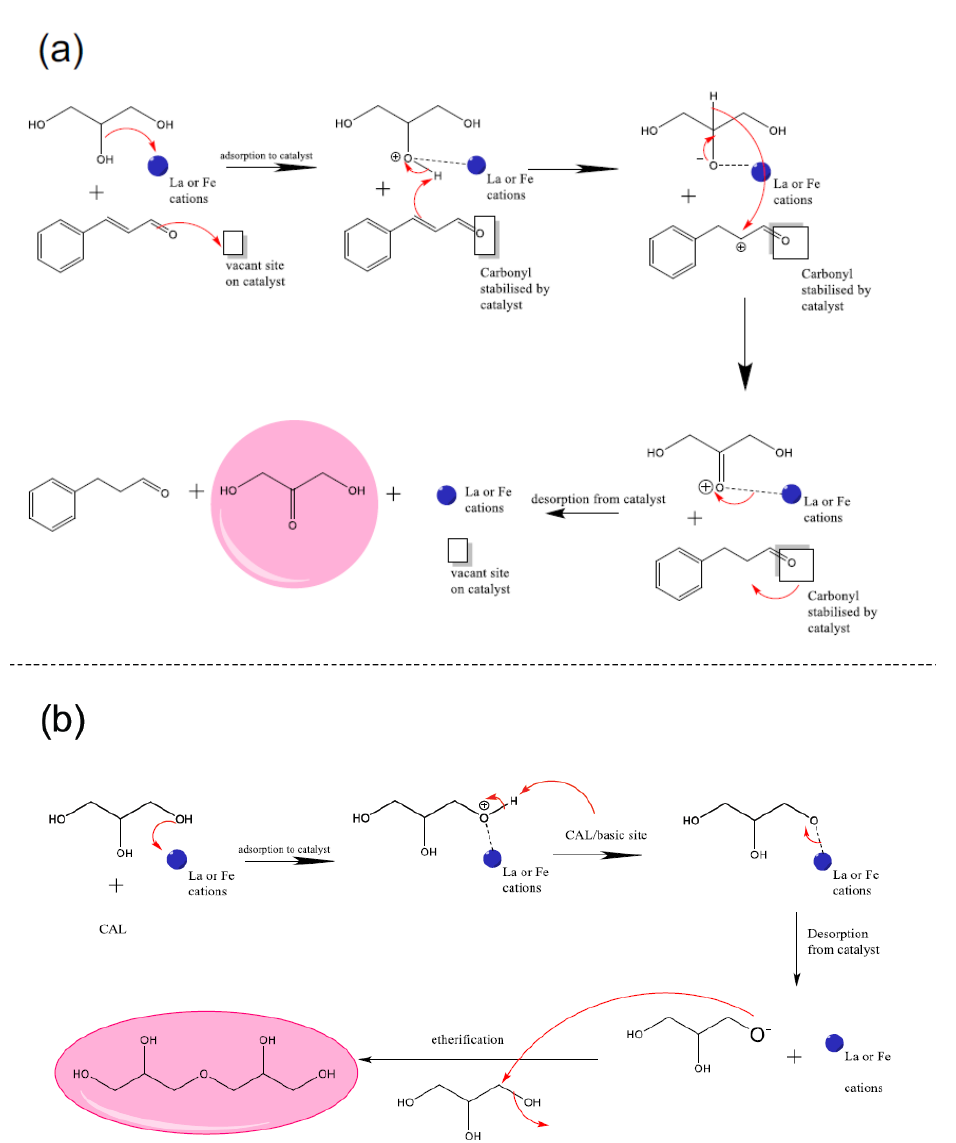
Scheme 4. Proposed mechanism showing glycerol transformations during ( a ) the formation of hydro-cinnamaldehyde from cinnamaldehyde and ( b ) glycerol etherification to diglycerol. The GC-MS confirmed the formation of the products and bi-products, as shown in Figure S1 in ESI. As per the GC-MS library, the hydro-cinnamaldehyde, cinnamyl-alcohol, and diglycerol were matched by 77%, 79%, and 78% respectively. The diglycerol mass spectra displayed fragmentation patterns with losses of CH 3 CO and C 4 H 9 O 3 equivalent to 43 and 105 amu. Hydro-cinnamaldehyde had peak fragmentations of 91, 105, and 78 amu with losses of 43 amu (CH 2 CHO), the highest. Cinnamyl alcohol had losses of 42 amu corresponding to C 2 H 2 O the highest. The products were further confirmed by proton 1 H-NMR spectra (Figure S3 in ESI) for the reactions represented in Table 2. The characteristic peaks for the substrate and products are cinnamaldehyde (C7; 7.6 ppm), cinnamyl alcohol (C9; 4.4 ppm), and hydro-cinnamaldehyde (C7 and C8; 2.8 and 2.9